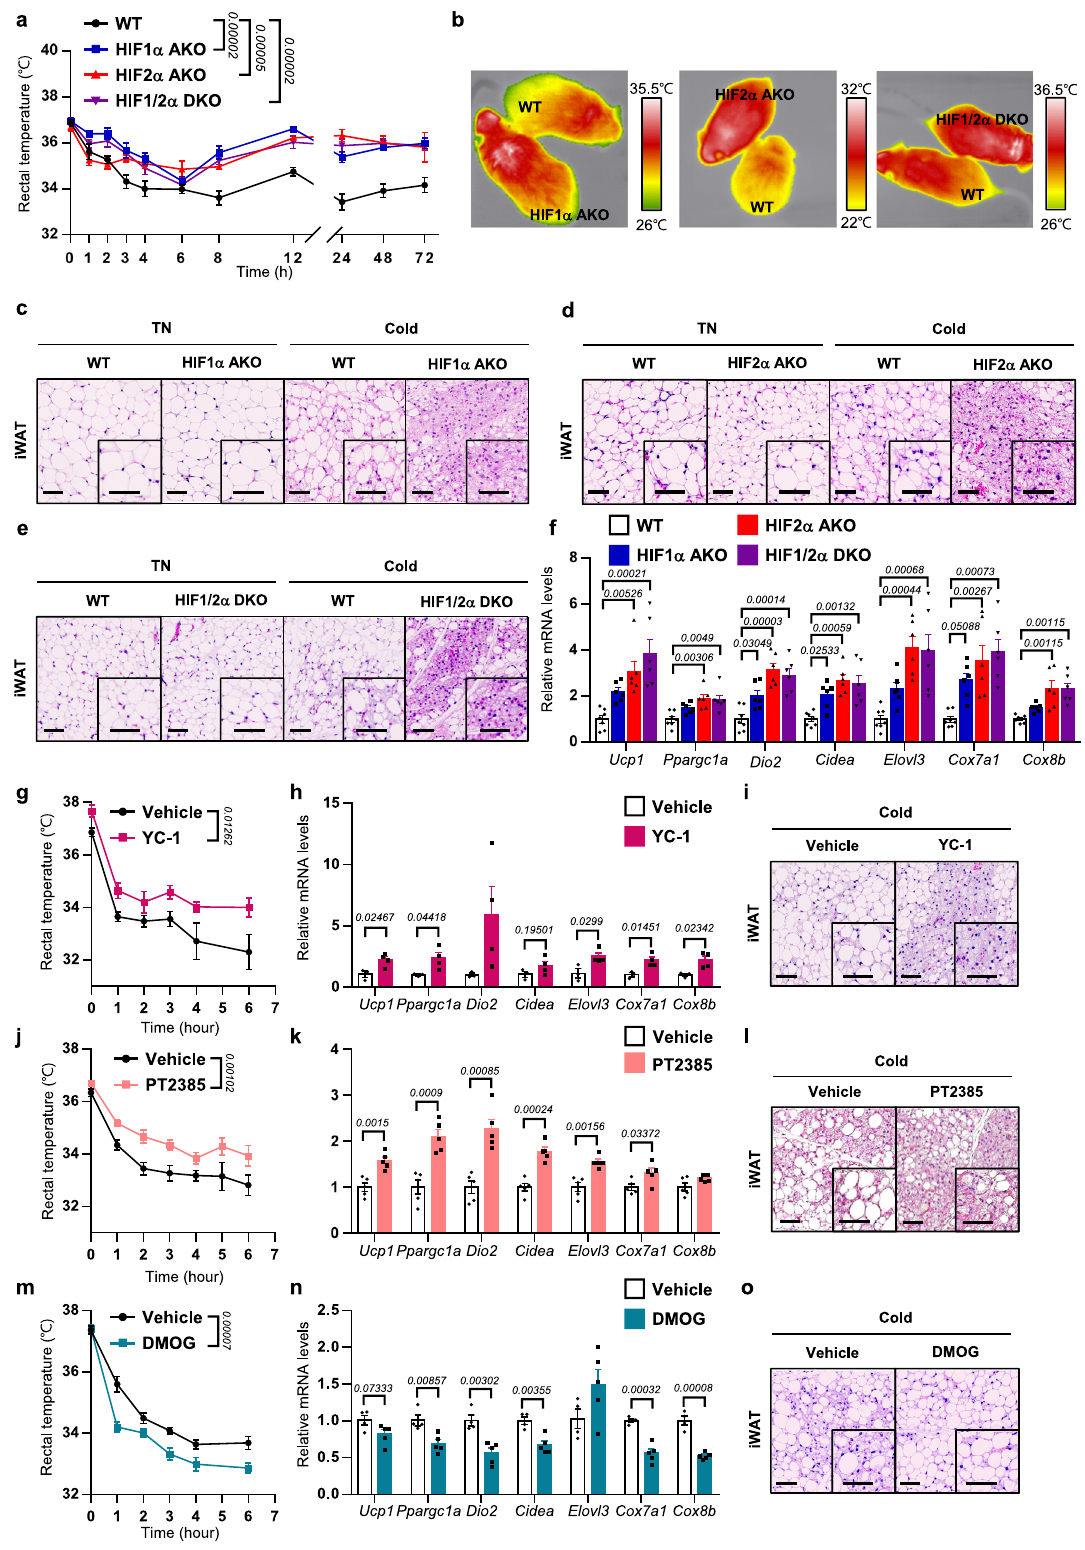
In beige adipocytes, HIF2 α ablation potentiates PKA signaling via PKA C α upregulation . To decipher the underlying mechanism(s) by which HIF2 α modulates thermogenesis, tran- scriptome pro fi les of iWAT were scrutinized. Compared to WT iWAT, HIF2 α AKO iWAT showed numerous